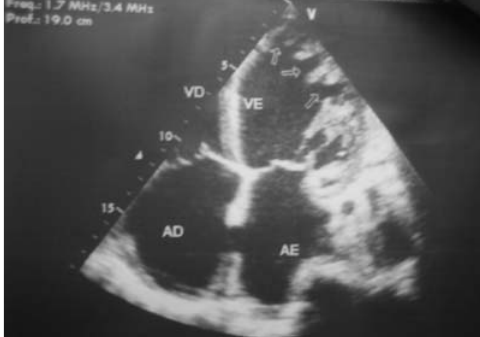
Figure 4 - Transthoracic achocardiography at apical 4-chamber (AFC) view showing patente foramen ovale, presence of numerous prominent tra- beculations and deep intertrabecular recesses. AD - right atrium; VC - right ventriculum; AE - left atrium; VE - left ventriculum